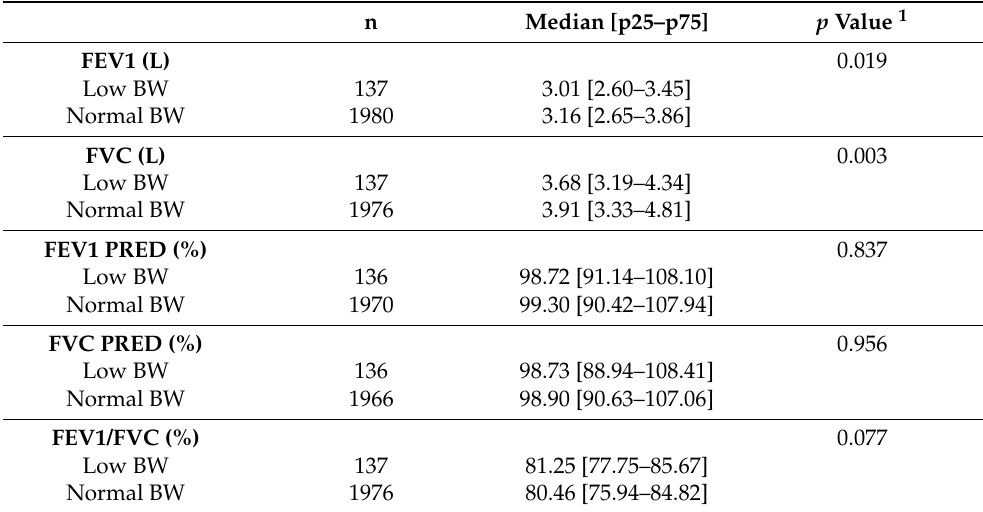
Table 3. Lung function measures by